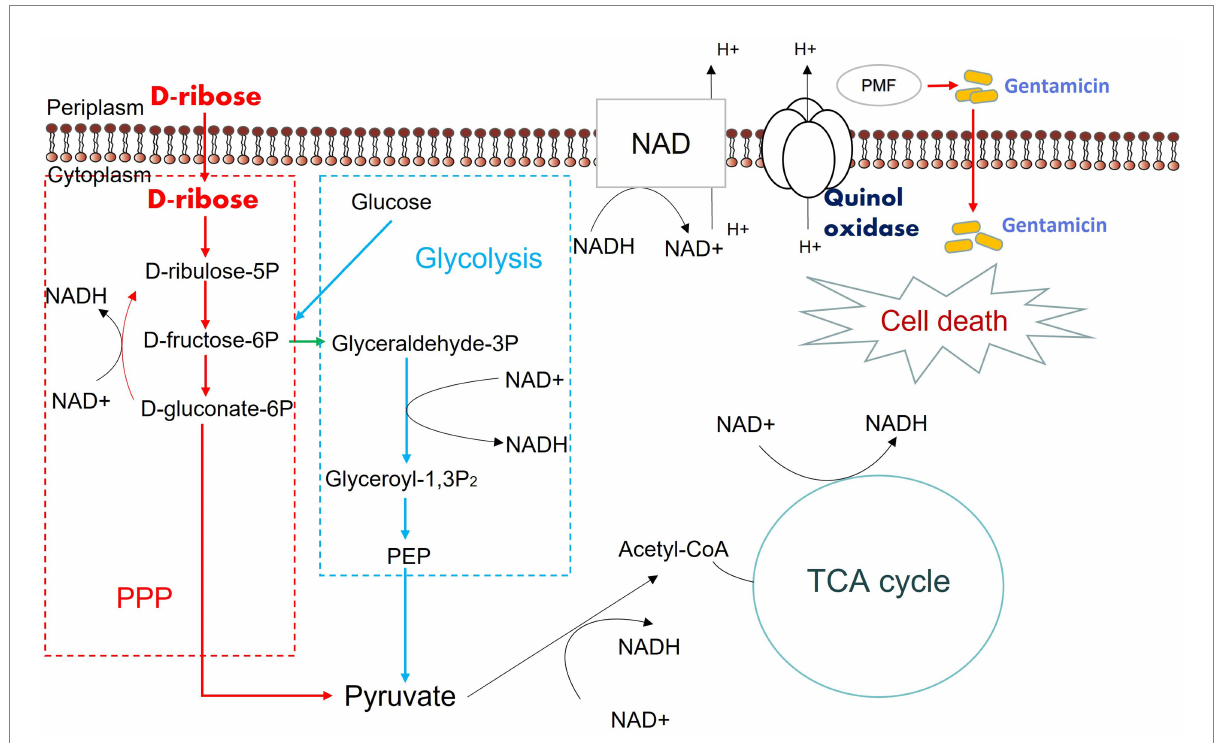
FIGURE 8 Mechanism of exogenous D-ribose promotes gentamicin treatment of drug-resistant Salmonella . D-ribulose 5P, D-ribulose 5-phosphate; D-fructose 6P, D-fructose 6-phosphate; D-gluconate-6P, 6-phospho-D-gluconate; Glyceraldehyde 3P, Glyceraldehyde 3-phosphate; Glyceroyl- 1,3P 2 , 3-phospho-D-glyceroyl phosphate; PEP,